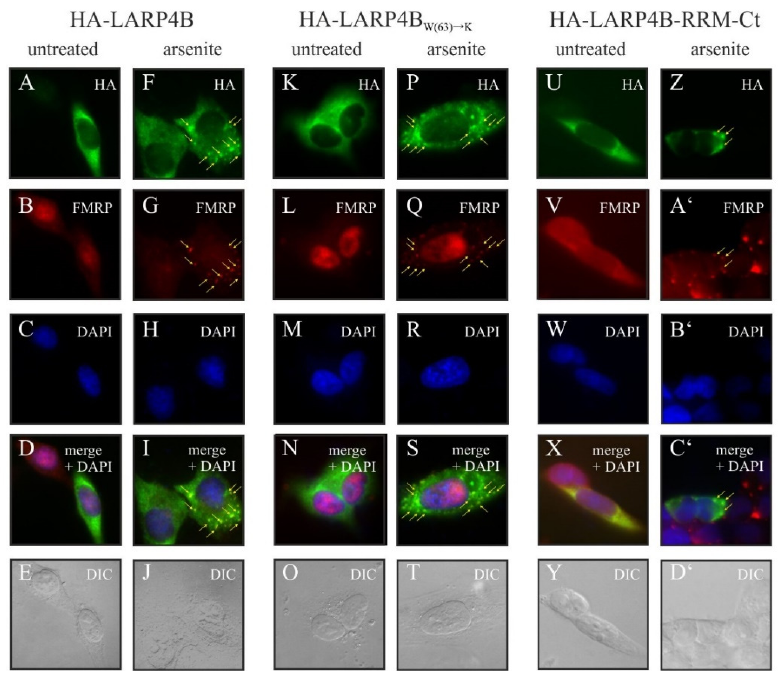
Figure 4. The C-terminus of LARP4B is sufficient to accumulate in stress granules. Upper part, depiction of the LARP4B constructs used for immunofluorescence. Lower part, immunofluorescence studies in HeLa cells transfected with the introduced constructs, using antibodies against Human influenza hemagglutinin (HA) and fragile X mental retardation protein (FMRP) as a stress granules marker protein. Cells were either mock-treated (panels A–E, K–O, U–Y) or treated with arsenite (panels F–J, P–T and Z–D’). SG are marked by arrows.